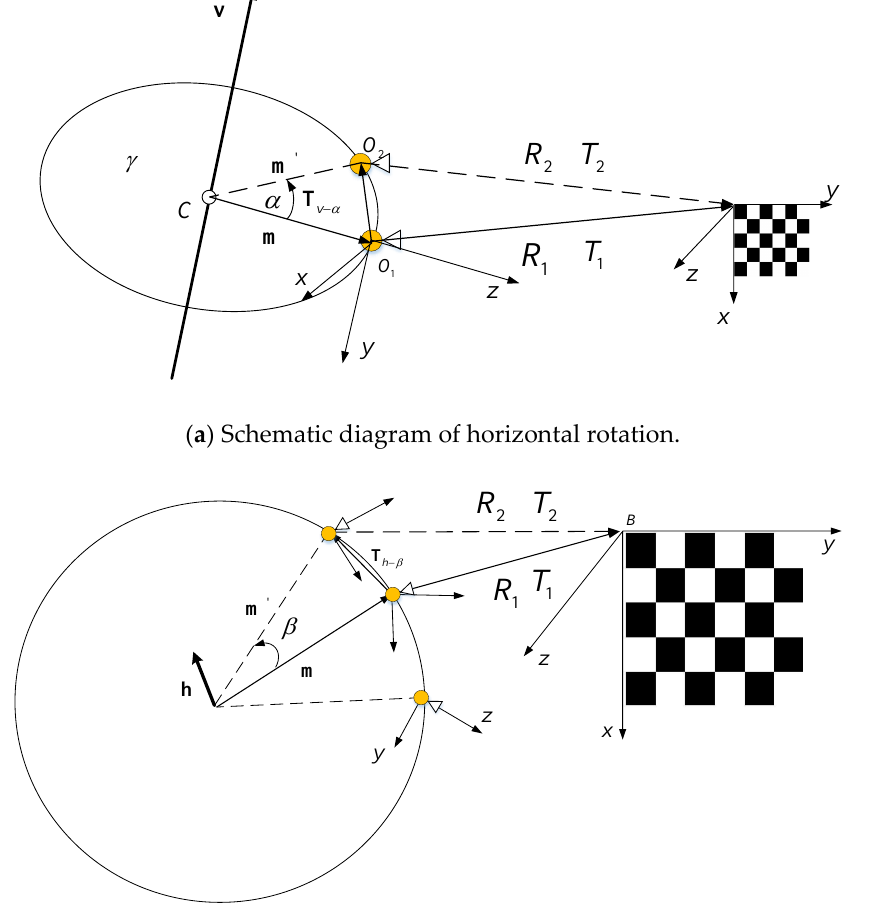
( b ) Schematic diagram of pitch rotation. Figure 5. Schematic diagram of horizontal rotation and pitch rotation. The optical center rotates from O 1 to O 2 around v